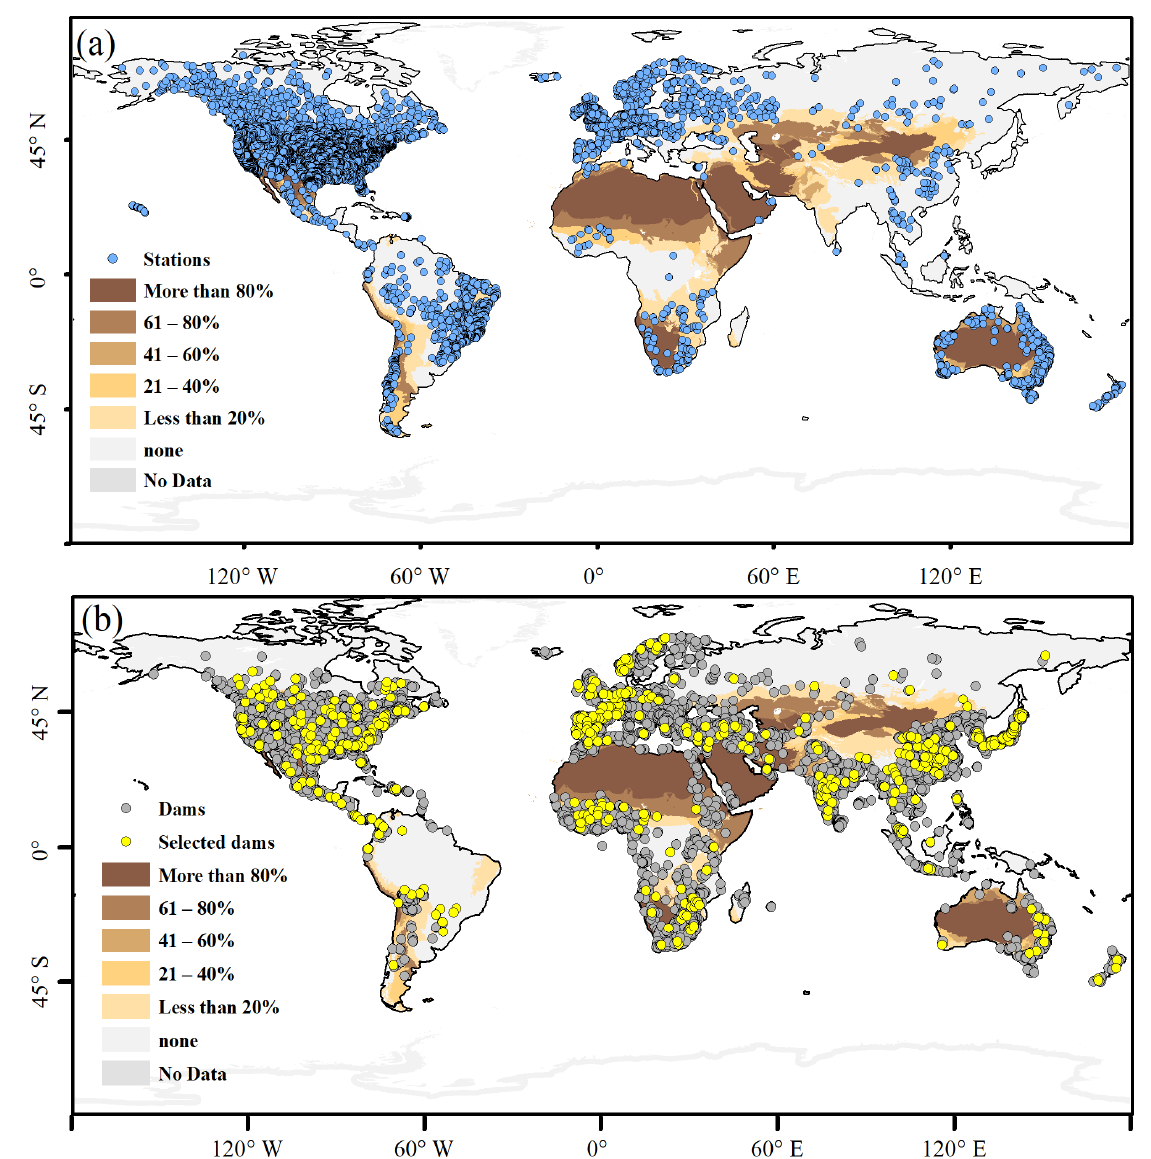
Figure 1. The spatial distribution of hydrological stations and dams. ( a ) The blue points indicate the selected the hydrological stations used in this study. ( b ) The global distribution of the dam is at the bottom. The grey points are the collected 7320 dams in the world, and the yellow points are selected 5182 dams located in the selected catchment boundaries from 1975 to 2017. Brown areas represent the arid regions of the world, and light and dark colors represent the percentage of arid land area.